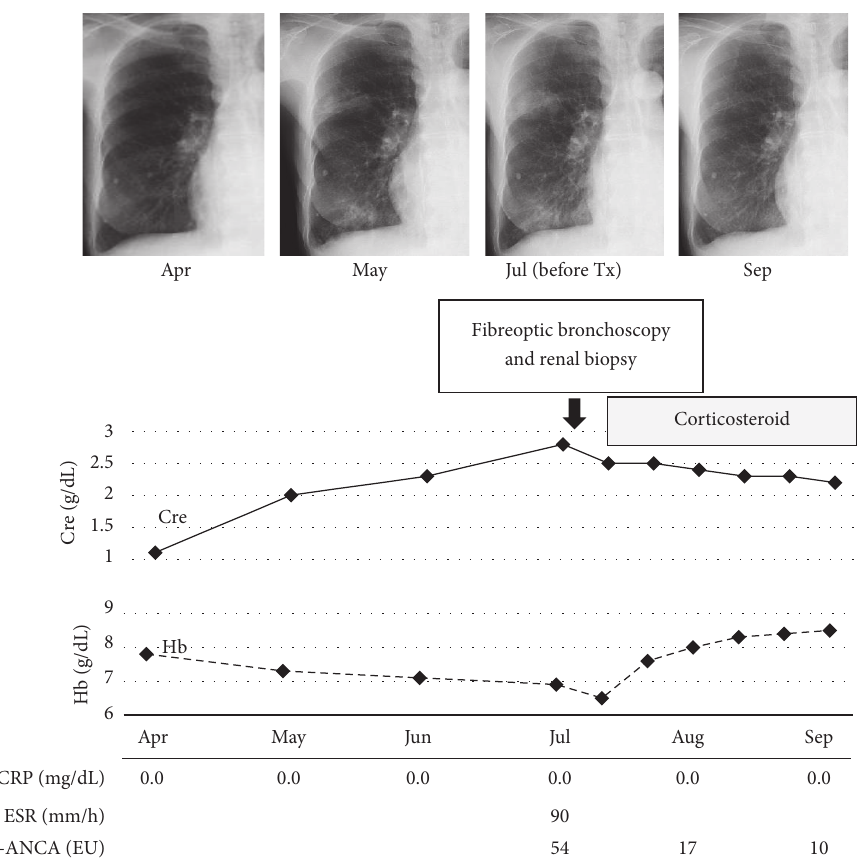
Figure 3: Clinical course of the MPA patient. Serial chest radiographs showed the clinical course of the pulmonary shadows in the right middle and lower lung fields. The solid line in the graph shows serum creatinine levels and the dashed line shows haemoglobin levels during the patient’s clinical course. Tx: treatment.